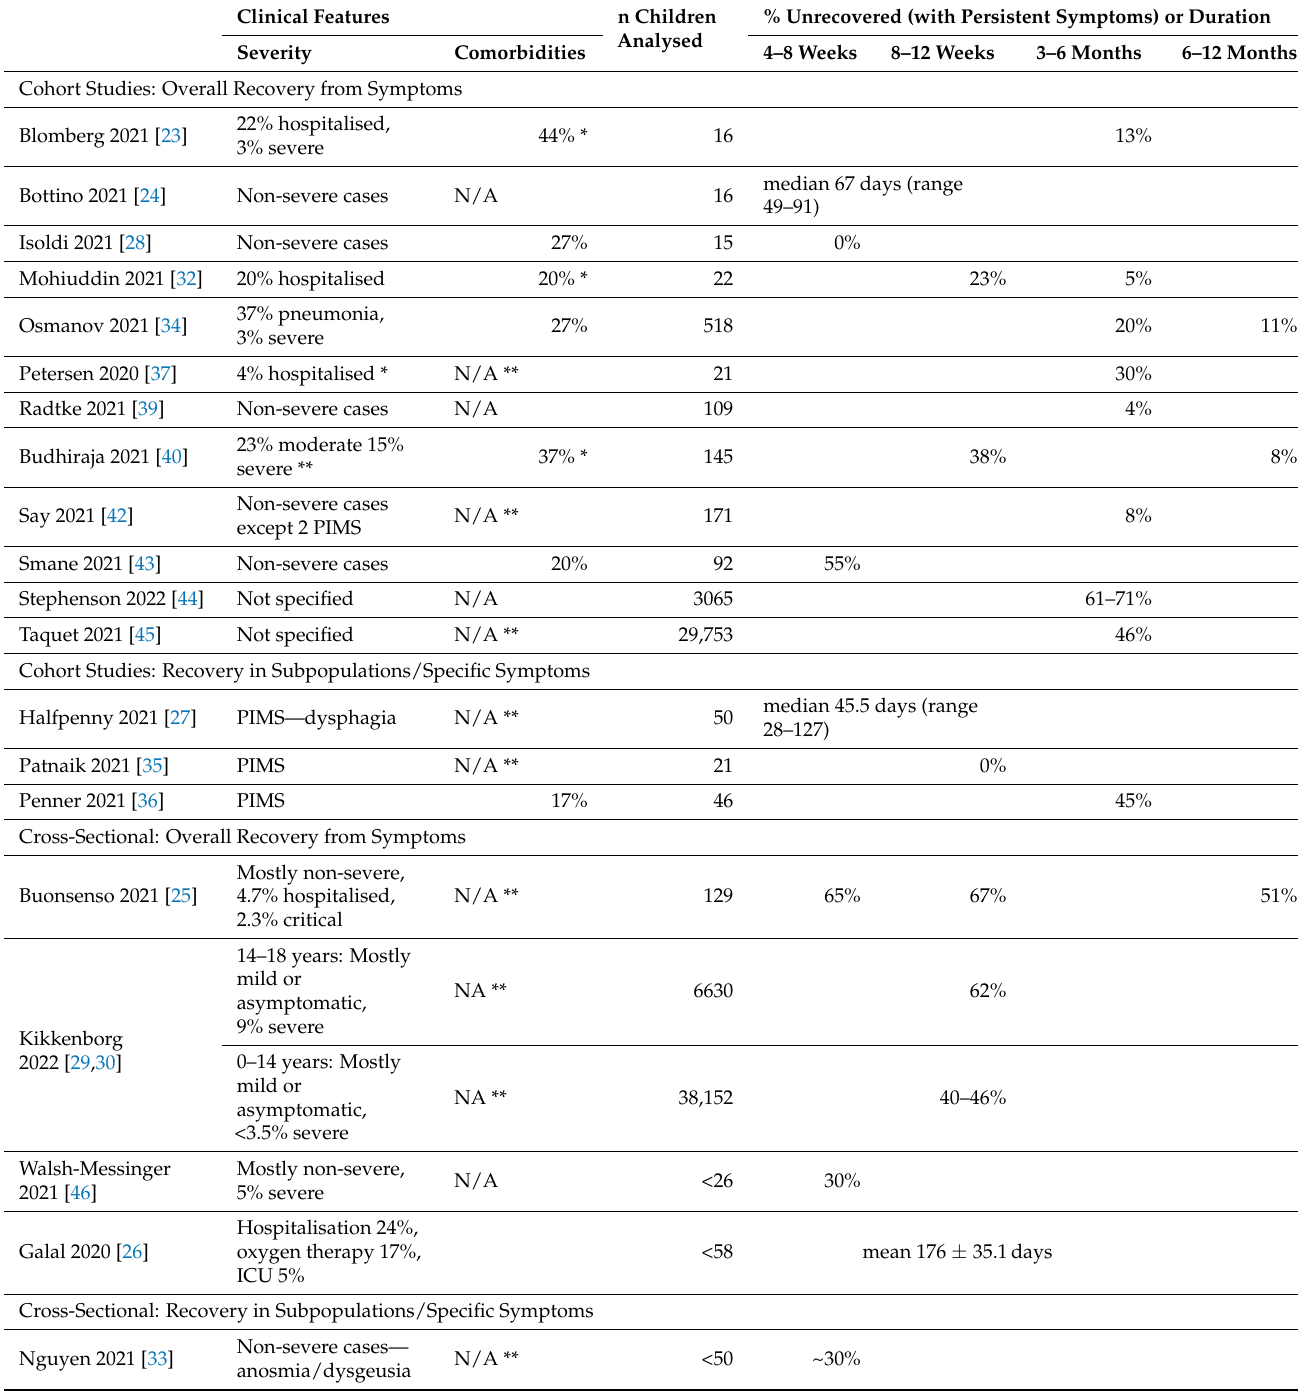
Table 3. Summary of studies reporting recovery/duration of